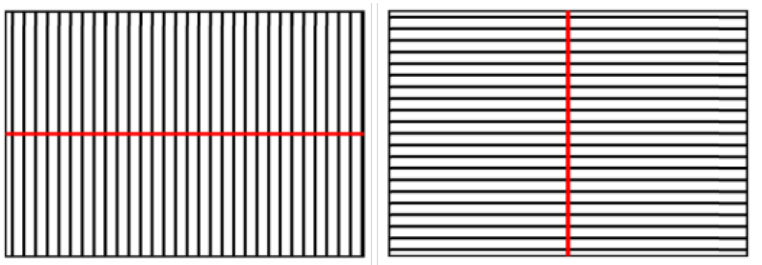
Figure 4. Measurements with the CL confocal microscope. The red line corresponds to the extracted profile.